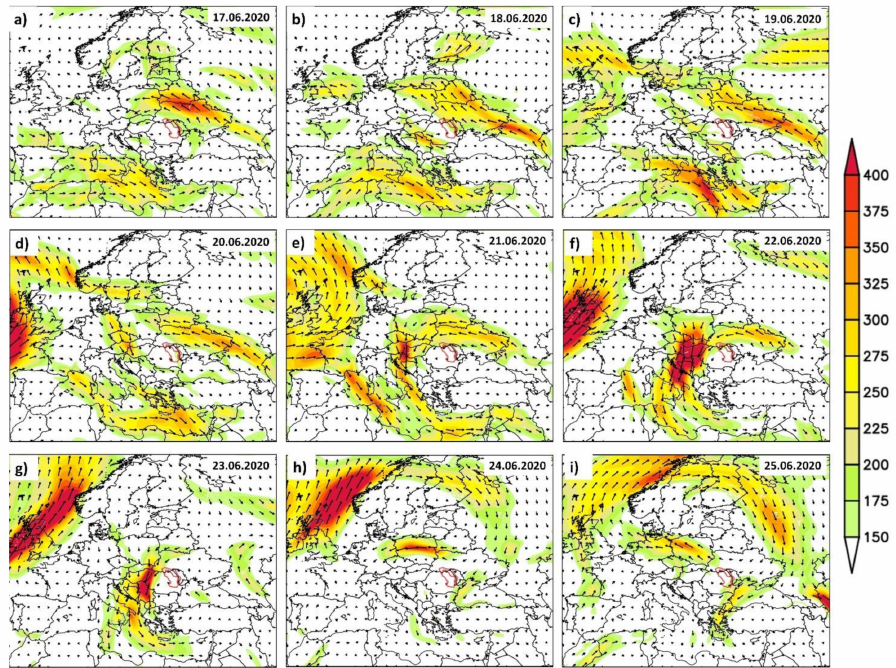
Figure 12. Magnitude (shaded colors) and direction (vectors) of the daily integrated water vapor transport (WVT) for: ( a ) 17